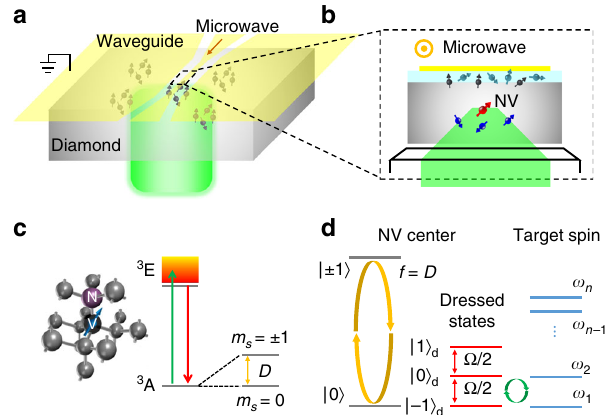
Fig. 1 Essence of the method for ZF-ESR spectroscopy at the nanoscale. a Sketch of the experimental setup. The diamond with shallow NV centers is adhered on a coplanar waveguide, which can radiate microwave from the central gold wire. b Sectional view of the central area of the setup. The red, blue (turquoise), and black arrows denote the NV center, inner (outer) target spins, and background spins, respectively. c Structure and energy levels of the NV center. The NV center can be excited from the ground states 3 A to the excited states 3 E by a laser pulse, and then decays back to 3 A with emission of photoluminescence. The spin transition between the ground states m s ¼ 0 j i and m s ¼ ± 1 j i with a zero- fi eld splitting D can be driven by microwave pulses. d Dressed states of the NV center being resonant with the target spin. The ground states ( 0 j i , ± 1 j i ) can be driven to the dressed states ( 0 j i , ± 1 j i ) by a resonant microwave pulse with d d frequency f . The energy level splitting in dress states can be tuned by the driving power Ω . The energy levels of the target spin are denoted as ω j = 1,2,..., n ). When Ω /2 matches the energy level splitting of the target j ( spin, the fl ip- fl op process between the NV center and the target spin